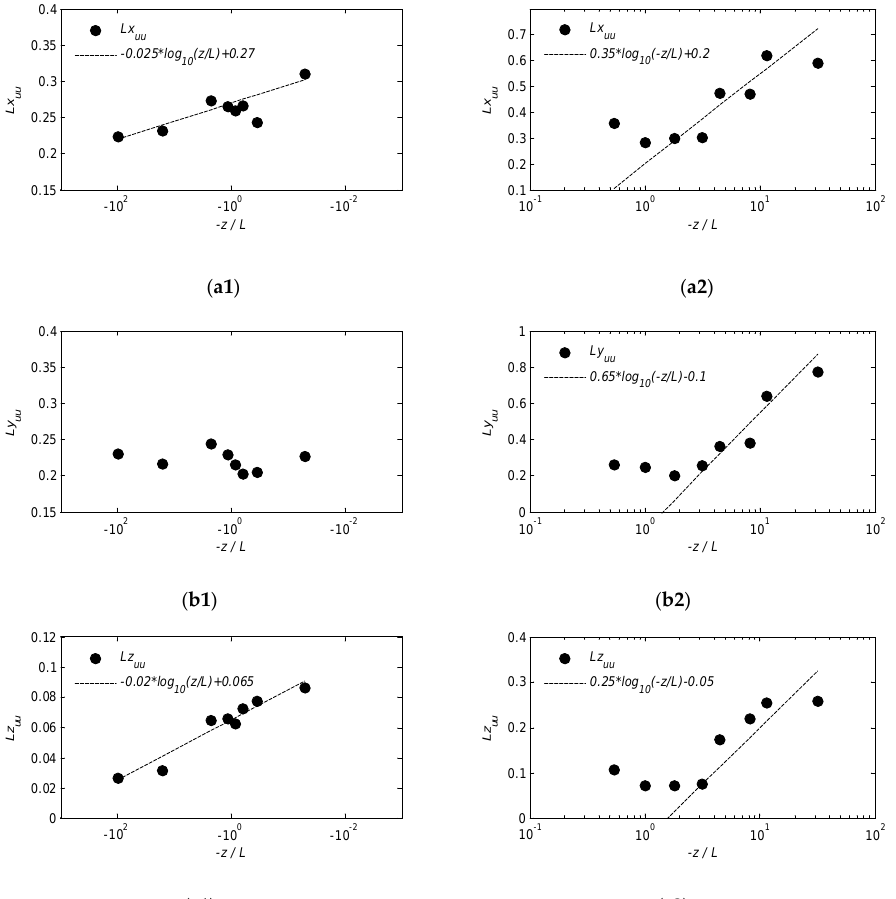
Figure 5. Extents of the 0.5 contours of the two-point correlations of the fluctuating velocity as functions of − z / L at a height 0.2 δ : ( a ) streamwise extent; ( b ) spanwise extent; and ( c ) wall-normal extent. The left and right columns are for stable and unstable conditions, respectively. For the neutral stability condition, Lx uu = 0.32 δ , Ly uu = 0.20 δ and Lz uu = 0.12 δ